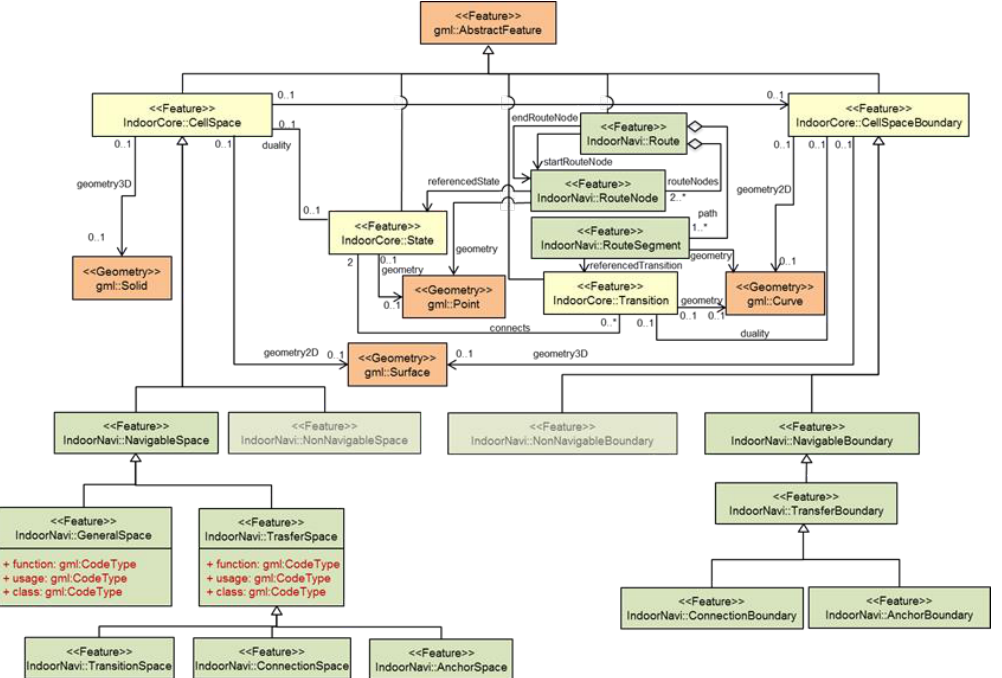
Figure 2. UML diagram of the IndoorGML core module and the navigation module (OGC, 2014).